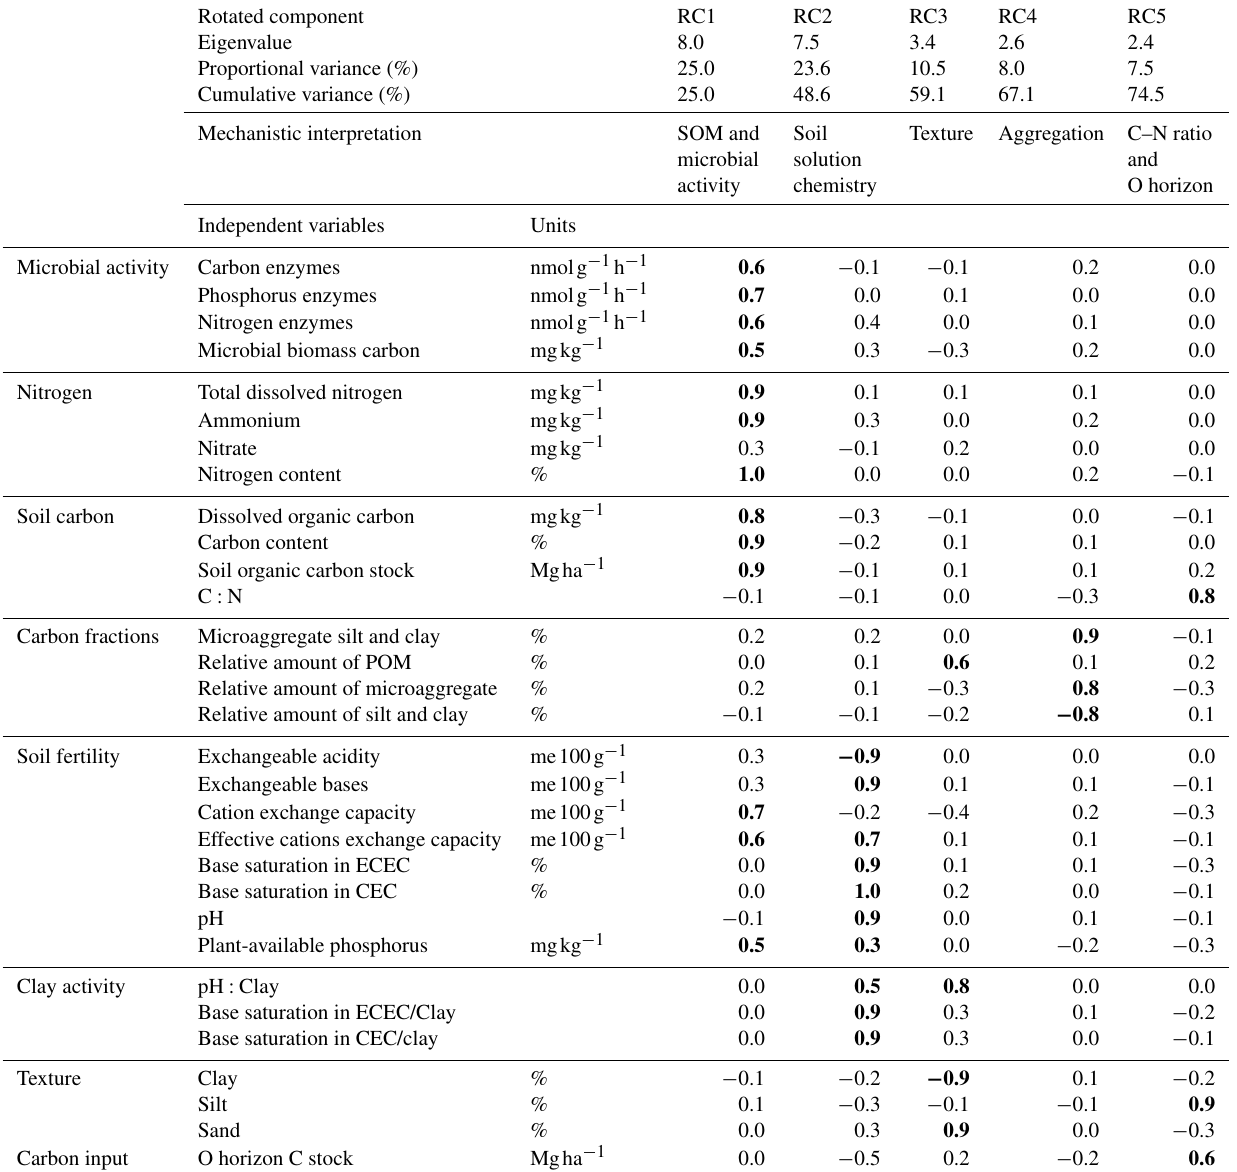
Table B1. Rotated principal component analysis for six principal components (RC) retained with eigenvalues > 1 and proportional vari- ance > 5%. The upper part of the table shows eigenvalues, individual and cumulative variance and mechanistic interpretation of specific RCs. The lower part represents loadings with values in bold showing the highest loadings of each RC ( r > 0.5). CEC is potential cation exchange capacity, and ECEC is effective cation exchange capacity. POM is particulate organic